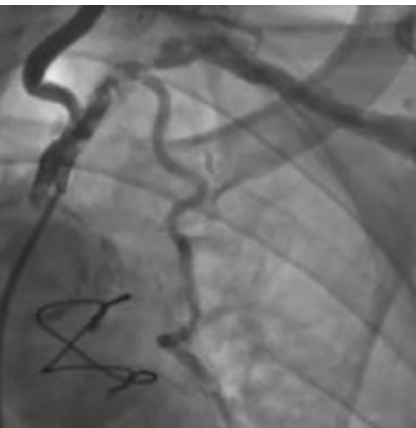
Figure 1: SA angiogram showing diffuse, severe atherosclerosis of the SA/LIMA bifurcation. SA, subclavian artery; LIMA, left internal mammary artery.